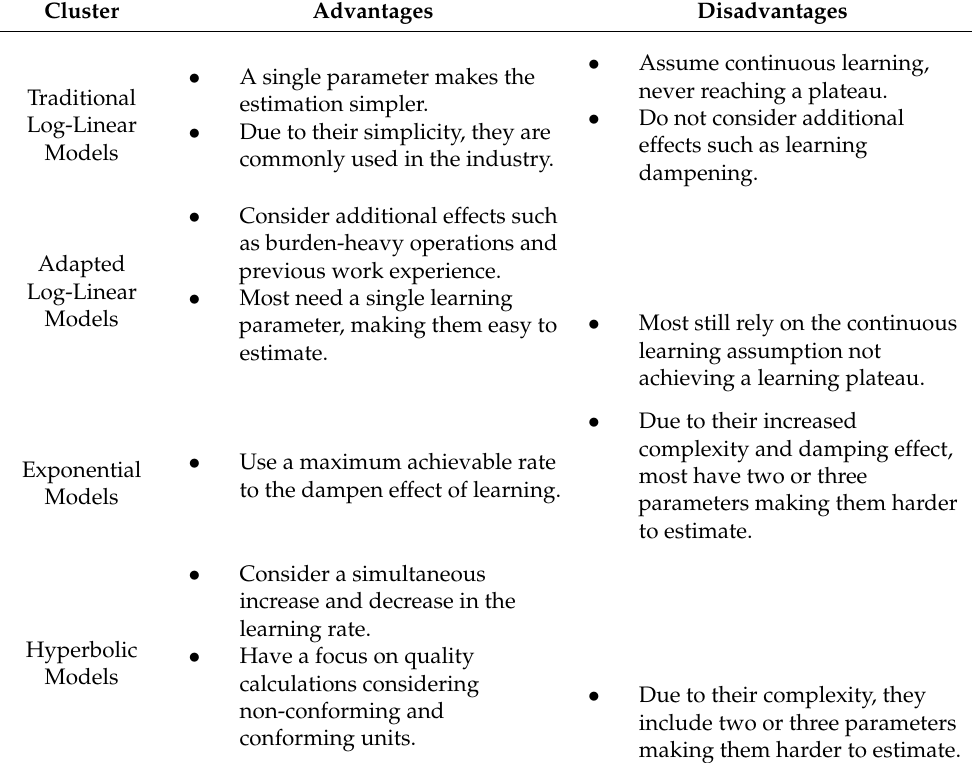
Table 1. Comparative analysis of the clusters of learning curve models